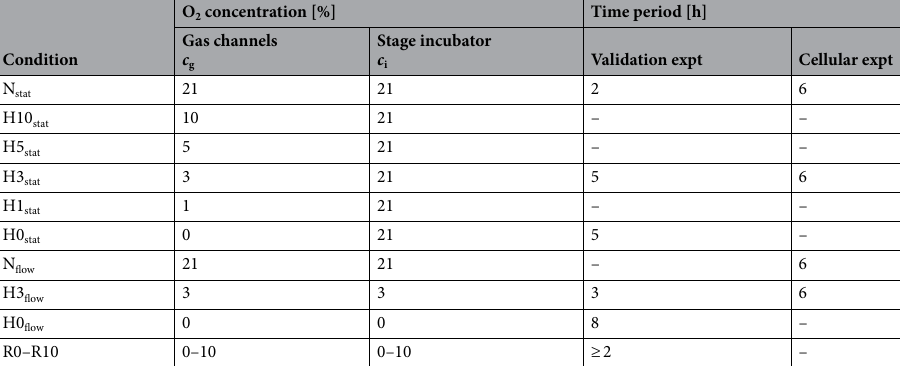
Table 1. Experimental conditions and settings: oxygen concentration, c g and c i , in the supplied gas mixtures to the gas channels and the stage incubator, respectively, and time period in validation experiment or cellular experiment. The normoxic condition is termed “N”, and a hypoxic condition is termed “H” accompanied with the value of c g . The conditions with and without flow exposure are noted with the subscripts “flow” and “stat”, respectively. The hypoxic static conditions for the reference in validation experiment are termed